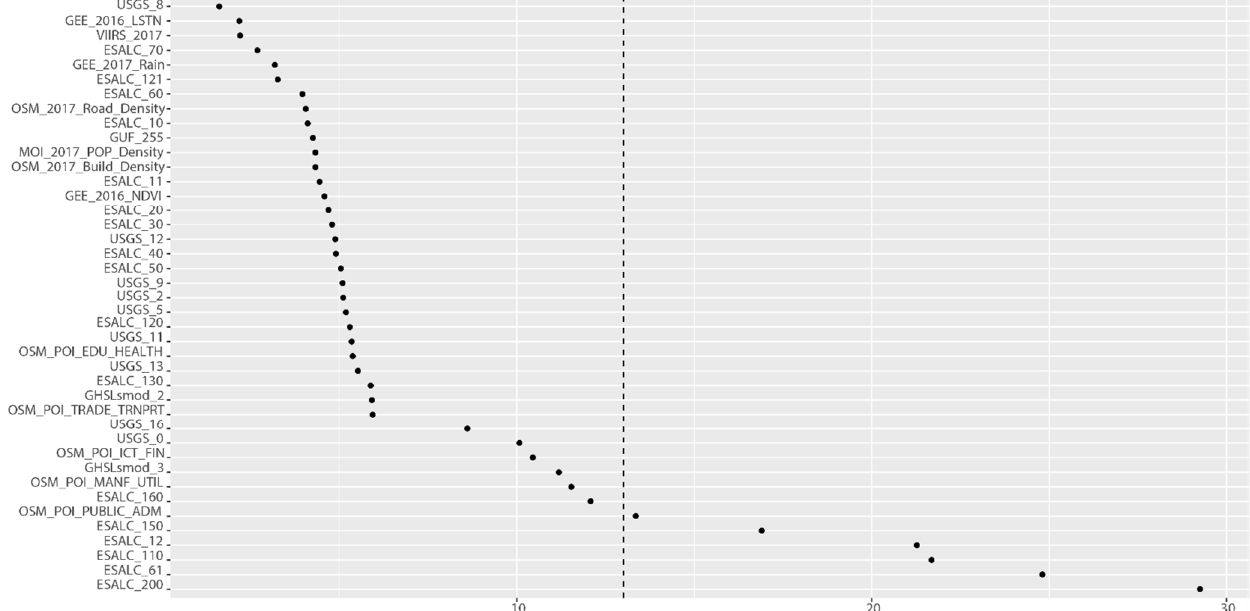
Figure 21. Result of Minimal Depth (MD) analysis on predicting MPI of 2017 (based on RF’s outcome). Source: Calculation and graphics generated by authors.